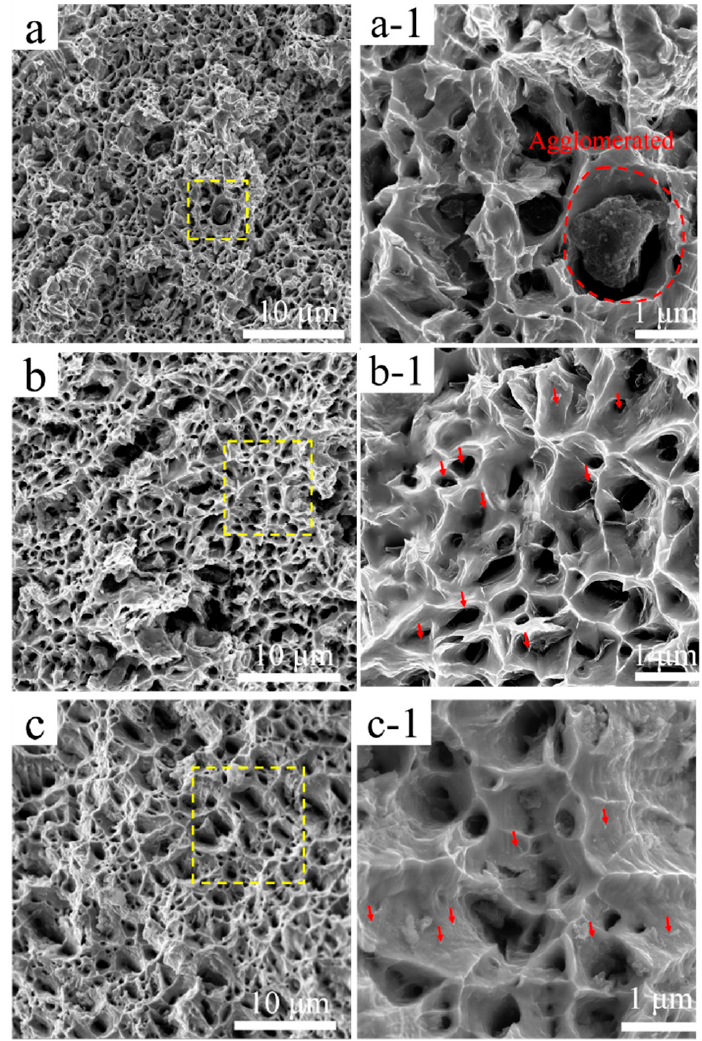
Figure 6. SEM images of tensile fracture of ( a , a-1 ) B-MWCNTs/Cu composite, ( b , b-1 ) Cu@MWCNTs/Cu composite, ( c , c-1 ) Ni@MWCNTs/Cu composite, red arrows marks MWCNTs. Figure 7 exhibits the average coefficient of friction (C OF) and wear rate on the two orthogonal friction test surfaces of pure Cu and MWCNTs/Cu composites. It can be seen from Figure 7a that the friction coefficient C (cid:107) (the friction test surface is parallel to the drawing direction) of MWCNTs/Cu composite samples is far lower than the friction coefficient C ⊥ (the friction test surface was perpendicular to drawing direction). For example, the C (cid:107) of Ni@MWCNTs/Cu composite sample is 33% lower than that of C ⊥ , and its W (cid:107) is 36% lower than that of W ⊥ . Similarly, the wear rate W (cid:107) (the friction test surface is parallel to drawing direction) is also far lower than the wear rate W ⊥ (the friction test surface is perpendicular to drawing direction), as shown in Figure 7b. The friction coefficient and wear rate of Ni@MWCNTs/Cu composite are the lowest. The friction coefficients C (cid:107) and C ⊥ are 0.21 and 0.28, respectively, which are reduced by 59% and 48% respectively compared with pure Cu sample. The wear rates W (cid:107) and W ⊥ are 0.41 × 10 − 5 mm − 3 · N − 1 · m − 1 and 0.6 × 10 − 5 mm − 3 · N − 1 · m − 1 , respectively, which are 77% and 66% lower than those of pure Cu